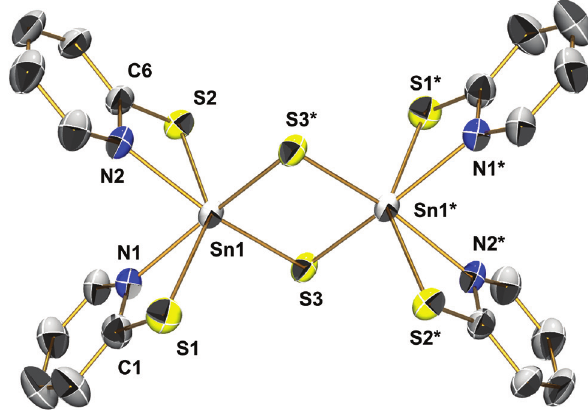
Figure 3 Molecular structures of Sn(PyS) structure. ORTEP/POV-RAY diagrams (Farrugia, 1997; POV-RAY 3.6, 2004) with thermal displacement ellipsoids are shown at the 50% probability level. Selected atoms are labeled and C-bound hydrogen atoms are omitted for clarity.